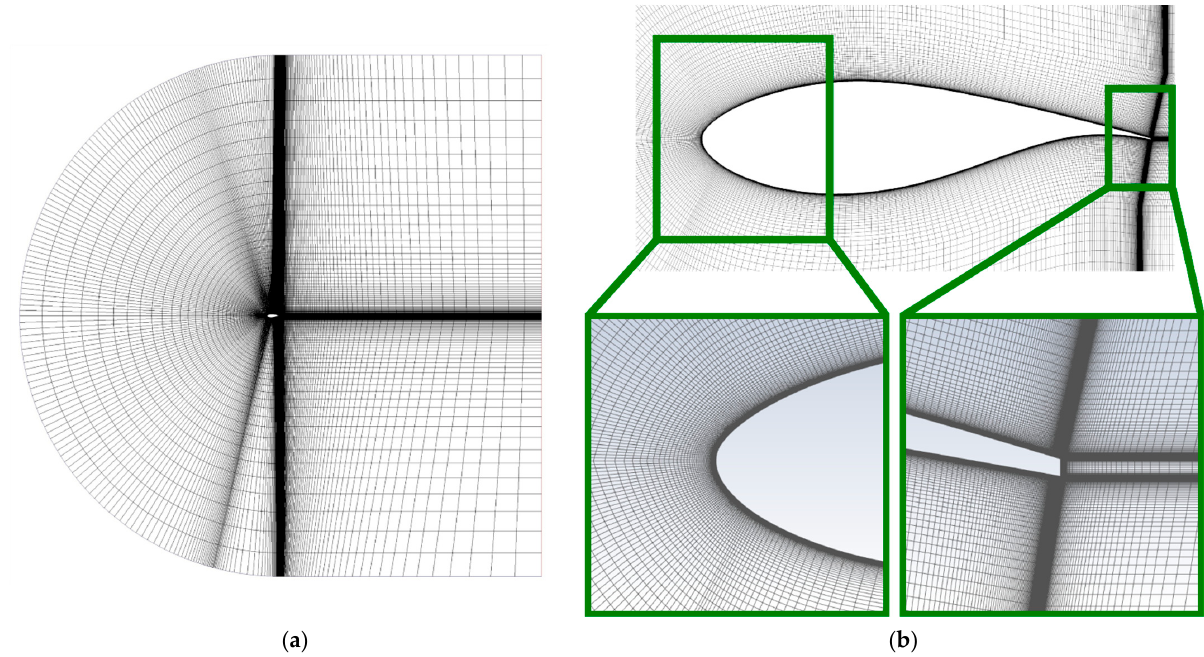
Figure 2. Mesh: ( a ) The mesh in the entire computing domain; ( b ) The distribution of the mesh around the airfoil.